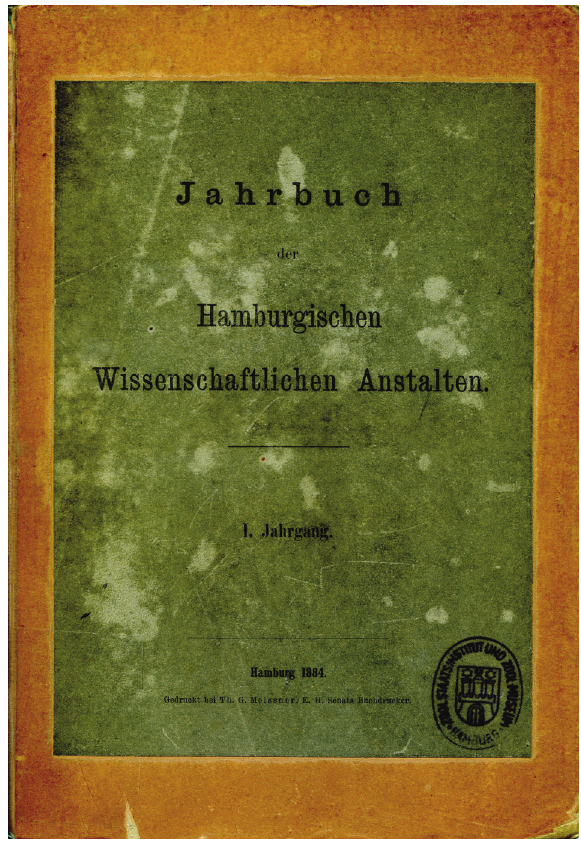
Figure 2. Title page of the “Jahrbuch der Hamburgischen Wis- senschaftlichen Anstalten” , published in September 1884, as first volume of a periodical journal from the Natural History Museum in